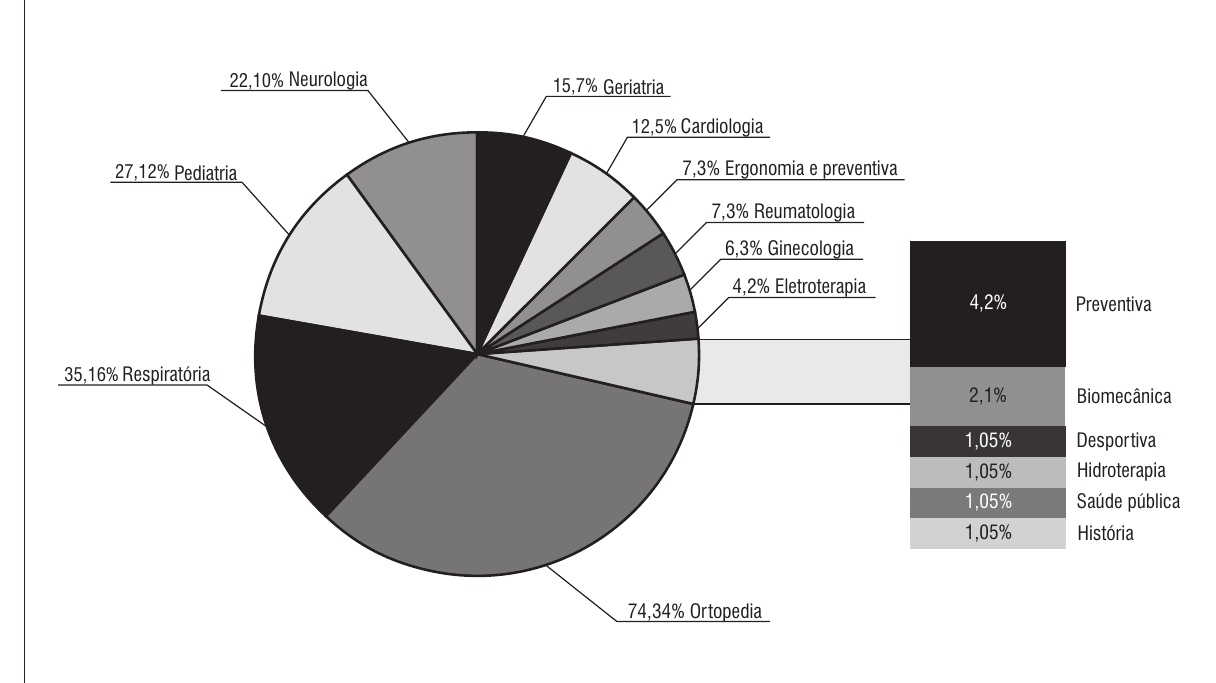
plina nos estudos